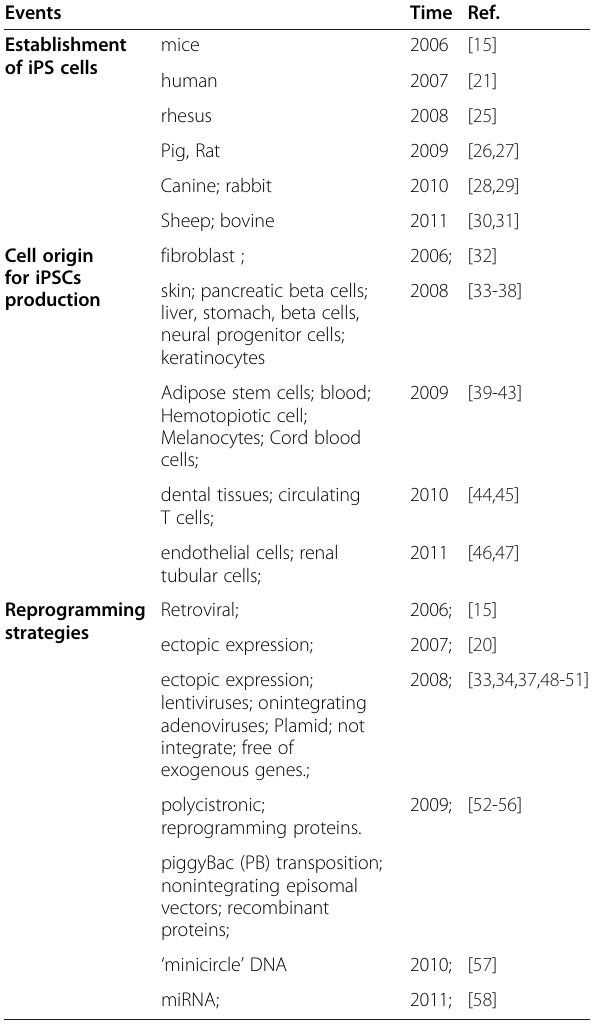
Table 1 Development of cell